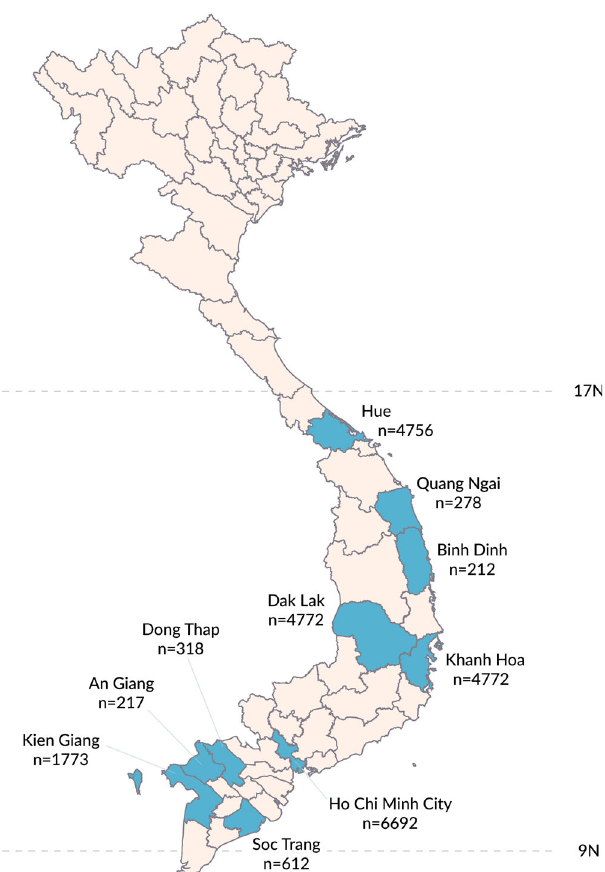
Fig. 1 Serum collection sites at provincial hospitals in southern Vietnam that participated in this study. Number of samples collected in each province is